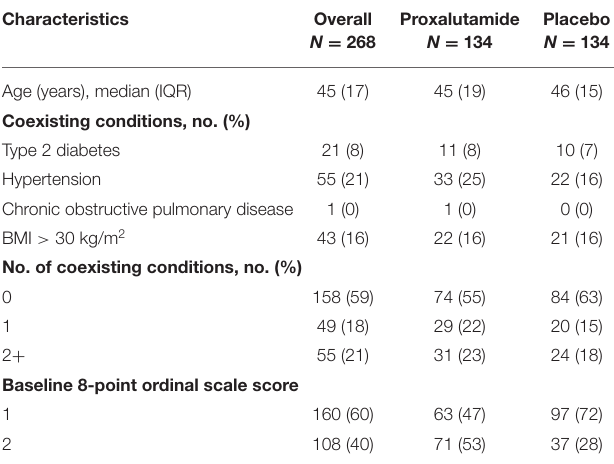
TABLE 1 | Baseline characteristics of the study arms. TABLE 2 | IQR, interquartile range; BMI, body mass index.